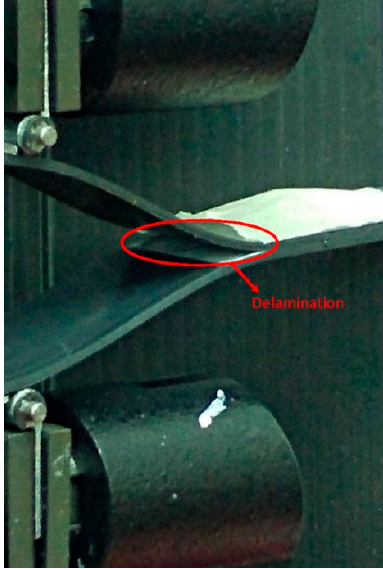
Figure 4. Crack opening during delamination test.